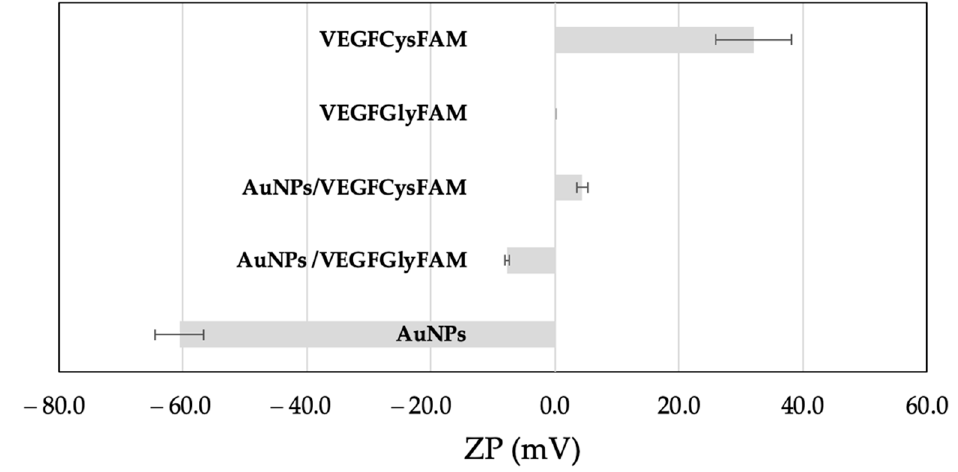
Figure 4. ζ -potential values of bare AuNPs, AuNPs/VEGF Cys FAM, AuNPs/VEGF Gly FAM and free peptides.